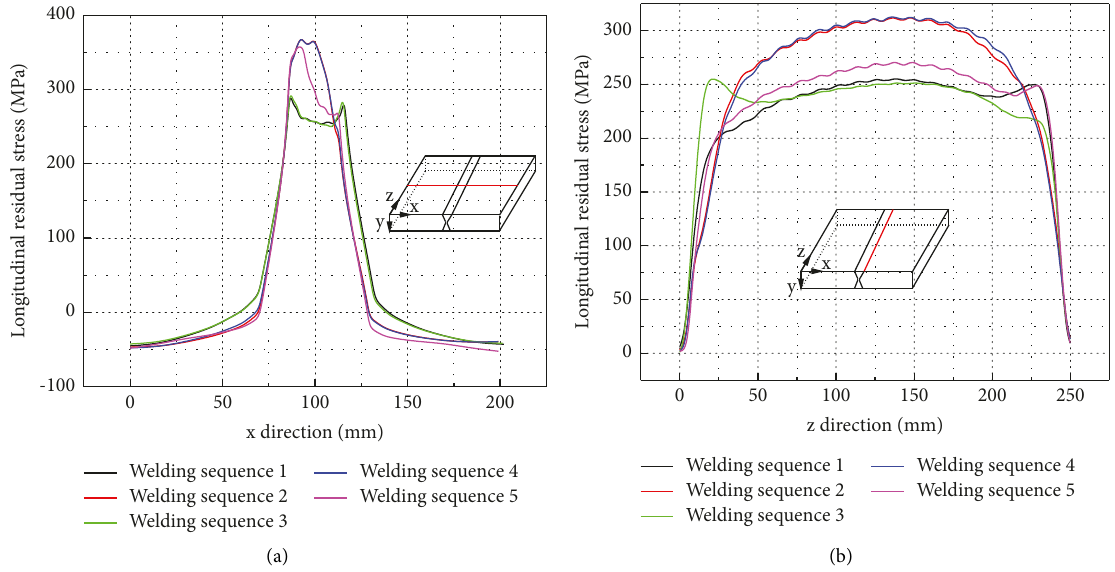
Figure 18: Comparison of the longitudinal residual stress. (a) Longitudinal residual stress of path 1. (b) Longitudinal residual stress of path 2.